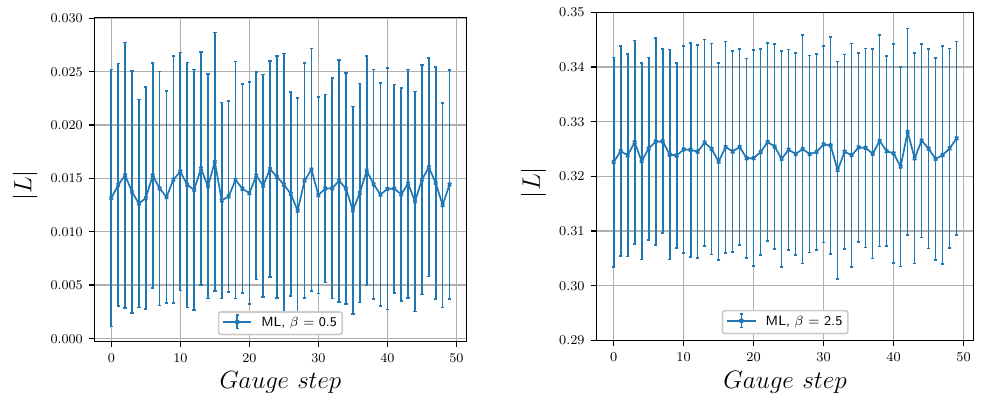
Figure 2: Gauge invariant behavior of numerically constructed Polykov loop at differ- ent phases of SU(2) theory as function of uniformly distributed global random gauge transformation